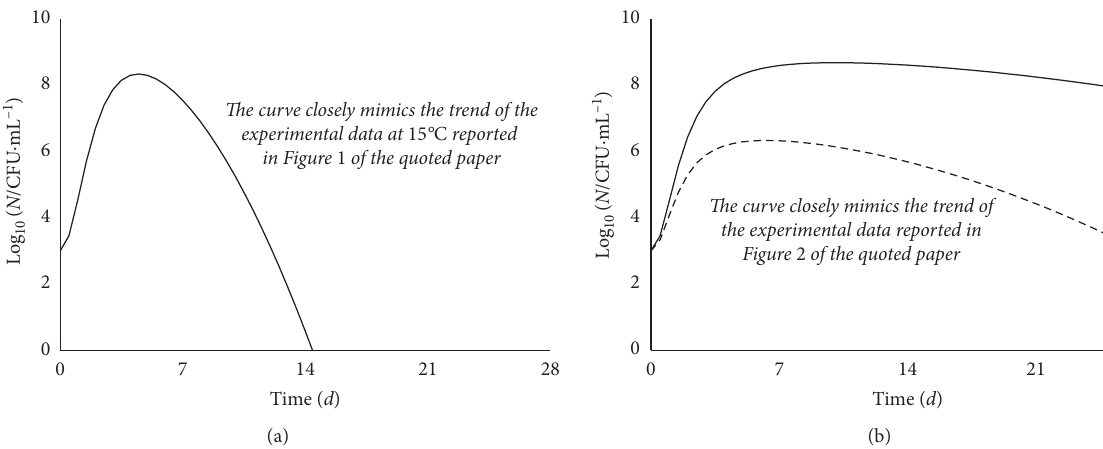
Figure 11: Growth and decay trend of E. coli in low-fat milk, data after [19]. (a) Pasteurized milk kept at 22 ° ; (b) pasteurized (full line) and unpasteurized (dotted line) milk kept at 15 ° C. The curves correspond to equation (11) and closely reflect the trend of the experimental data (not reliably transferable from the figures of